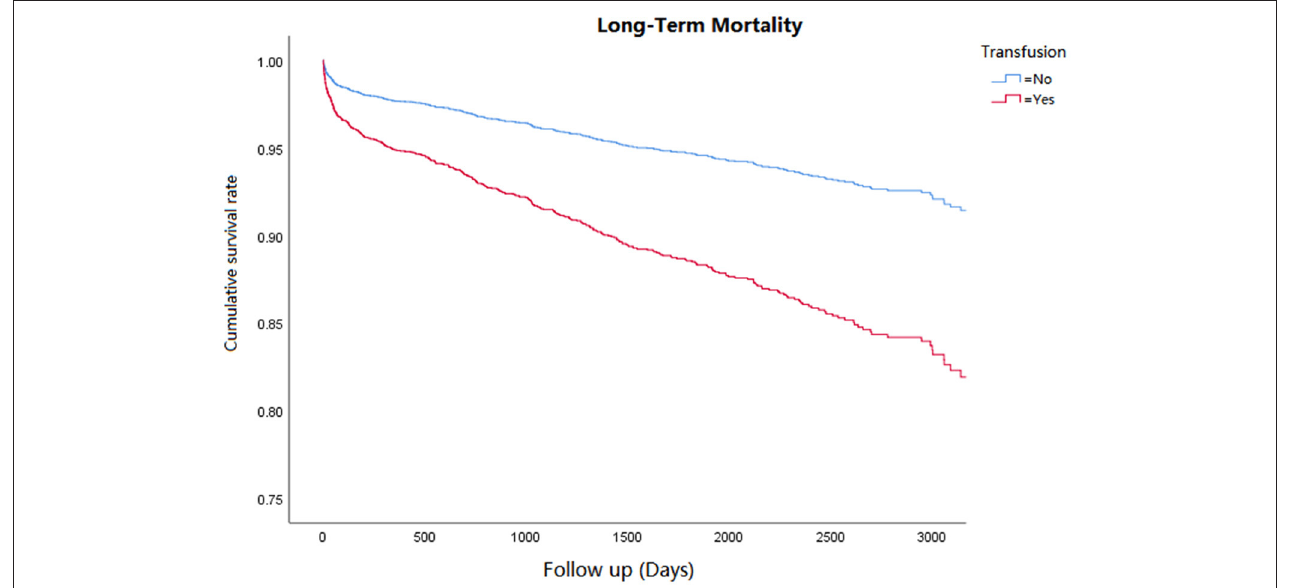
FIGURE 3 | Correlation between perioperative red blood cell transfusion and long-term mortality.